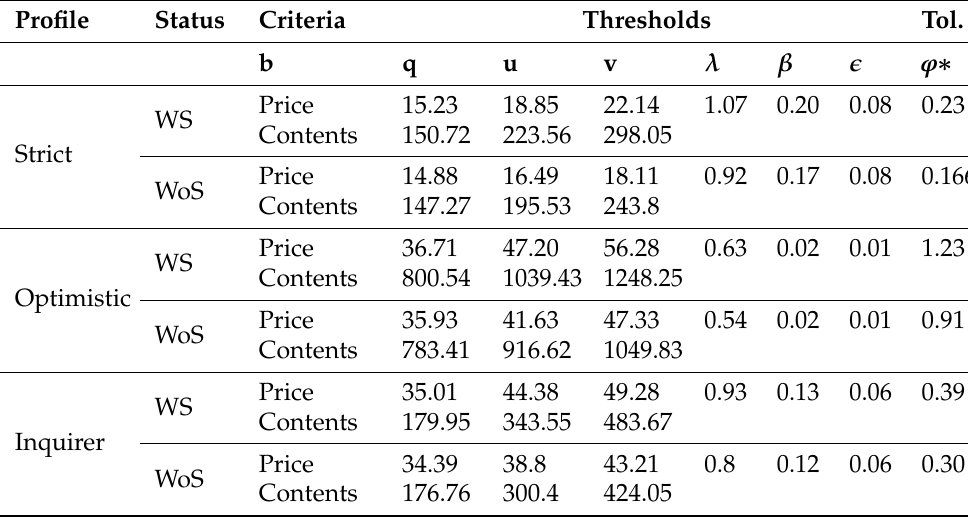
Table 22. Information from three individuals under studies with different decision